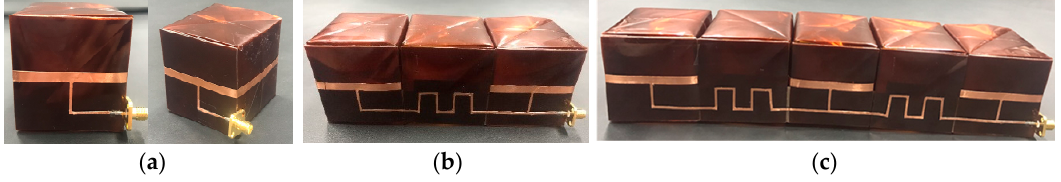
Figure 6. Fabricated samples: ( a ) Single antenna element, ( b ) two-element antenna array and ( c ) three-element antenna array.